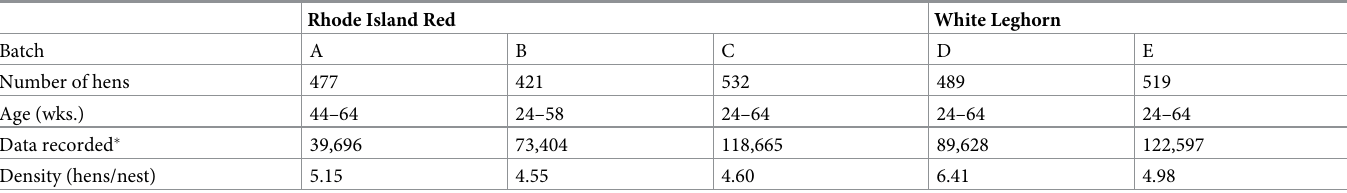
Table 1. Data recorded by individual electronic